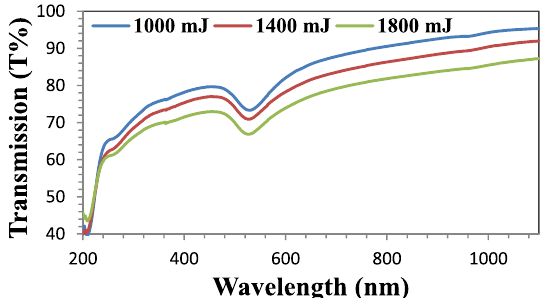
Figure 9. Transmission spectra of pure AuNPs at three laser ablation energies.